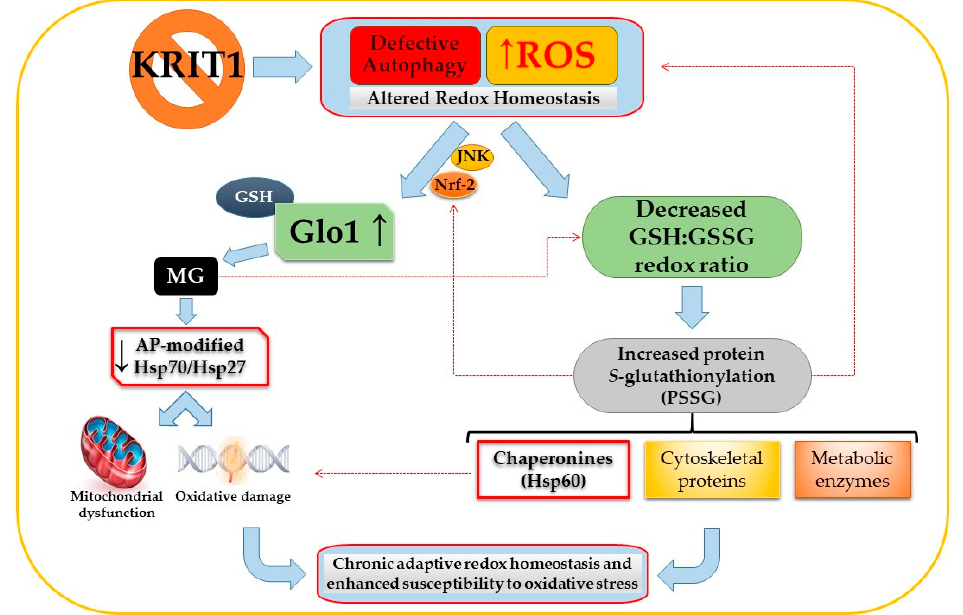
Figure 2. Potential interplay between methylglyoxal (MG)-mediated glycation and S-glutathionylation pathways induced by KRIT1 ( Krev interaction trapped 1 ) loss-of-function. The impairement of intracellular redox homeostasis caused by KRIT1 loss-of-function leads to a reactive oxygen species (ROS)-dependent sustained activation of the JNK-Nrf2 (c-Jun N-terminal kinase -nuclear factor erythroid 2-related factor) pathway and upregulation of downstram targets, including Glyoxalase 1 (Glo1). In turn, Glo1 upregulation results in decreased intracellular levels of cytoprotective MG adducts, including argpyrimidine (AP)-modified heat-shock proteins (HSP) 27 and 70, leading to an increased cell susceptibility to oxidative damage and mitochondria-dependent apoptosis. Concomitantly, KRIT1 loss-of-function a ff ects the glutathione (GSH) redox system, causing a significant decrease in the GSH:GSSG redox ratio and an increase in the S-glutathionylation of important structural and regulatory proteins, including metabolic enzymes; cytoskeletal proteins; and chaperonines, such as the HSP60. A potential interplay between the MG-mediated glycation and S-glutathionylation pathways may also occur, including the modulation of the GSH:GSSG redox ratio by MG and the contribution of S-glutathionylation to ROS production and Nrf2 activation (hatched red lines), leading to a synergistic contribution to the chronic adaptive redox homeostasis and enhanced cell susceptibility to oxidative stress associated with KRIT1 loss-of-function mutations. Eventually, these synergistic pathological e ff ects might therefore culminate in cerebral cavernous malformation (CCM) disease onset and severity. See text for details.